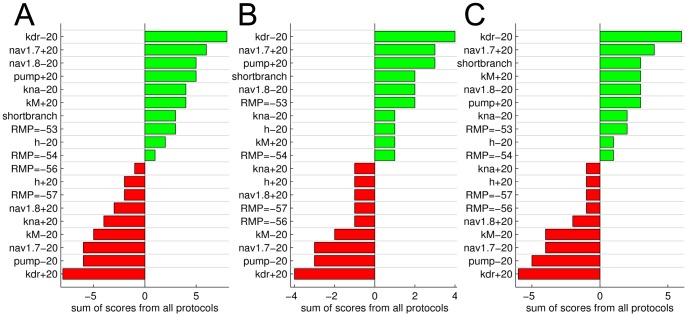
Results from all stimulation protocols weighed together by use of the scoring system.Large bars should be interpreted as strong candidates for explaining what change makes a CMi fibre more CM-like (green) or unlike (red). The results suggest that, compared to CMi fibres, CM fibres have less Kdr channels, more NaV1.7 channels, etc. (A): Exponentially increasing score lines (as in Figures 3 and 4): ±A·(j/N)2, with j = 1,2,…,N. For ADSmax: A = 3.5, N = 4; For Nfail: A = 25, N = 2; For CV: A = 6, N = 3; For SN1max: A = 40, N = 2; For SN1max: A = 60, N = 2. (B): Like (A) but with fewer exponentially separated score lines: For ADSmax: N = 3; For Nfail: N = 1; For CV: N = 2; For SN1max: N = 1; For SN1max: N = 1. (C): Similar to (A) but with linearly separated score lines: ADSmax: ±1,2,3,4; Nfail: ±10,20; CV: ±2,4,6; SN1max: ±20,40; SN2max: ±30,60.